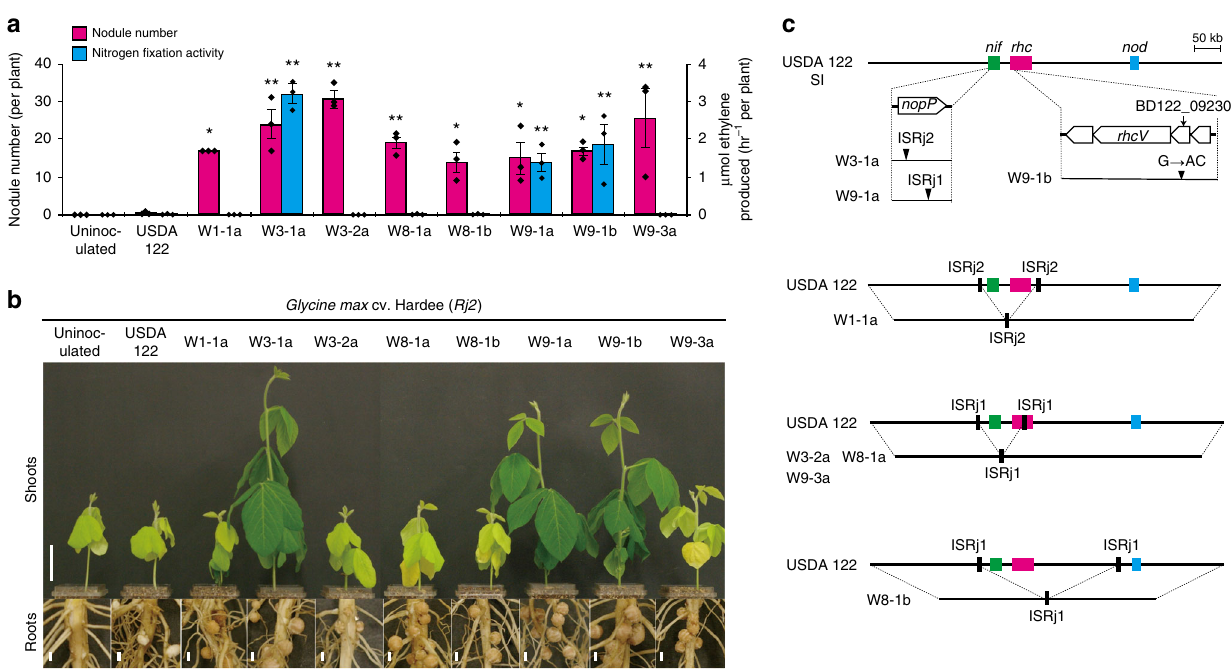
Fig. 2 Characterization of spontaneous mutants overcoming Rj2 -mediated incompatibility. a Number of root nodules and nitrogen fi xation activity of the roots of G. max cv. Hardee at 28 days after inoculation with USDA 122 and its spontaneous mutants. The data of nodule number shown are representative of two independent experiments. Nitrogen fi xation activity was measured by acetylene reduction assay. Error bars show SEM ( n = 3). Signi fi cant differences from USDA 122 by Dunnett ’ s multiple comparison test: * P < 0.05, ** P < 0.01. b Shoots and roots of G. max cv. Hardee ( Rj2 ) at 28 days after inoculation with USDA 122 or its spontaneous mutants. Scale bars, 5 cm (for shoots) or 0.5 cm (for roots). c Positions of mutations in the genomes of spontaneous mutants. Bold horizontal lines indicate the symbiosis island (SI, 672 kb). ISRj1 and ISRj2, insertion sequence